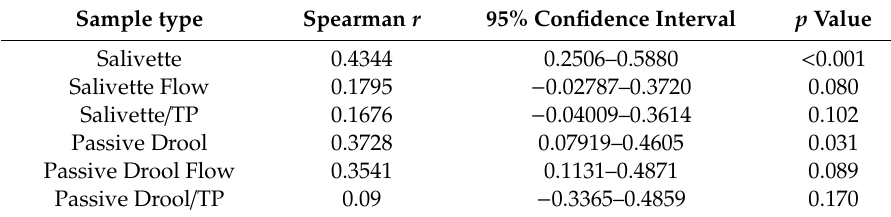
Table 3. Correlation data between uric acid in serum and